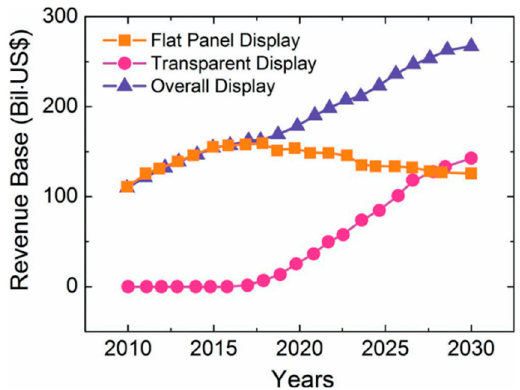
Figure 2. Transparent display market. Reproduced with permission from Ref. [2]. Copyright 2012 Wiley.